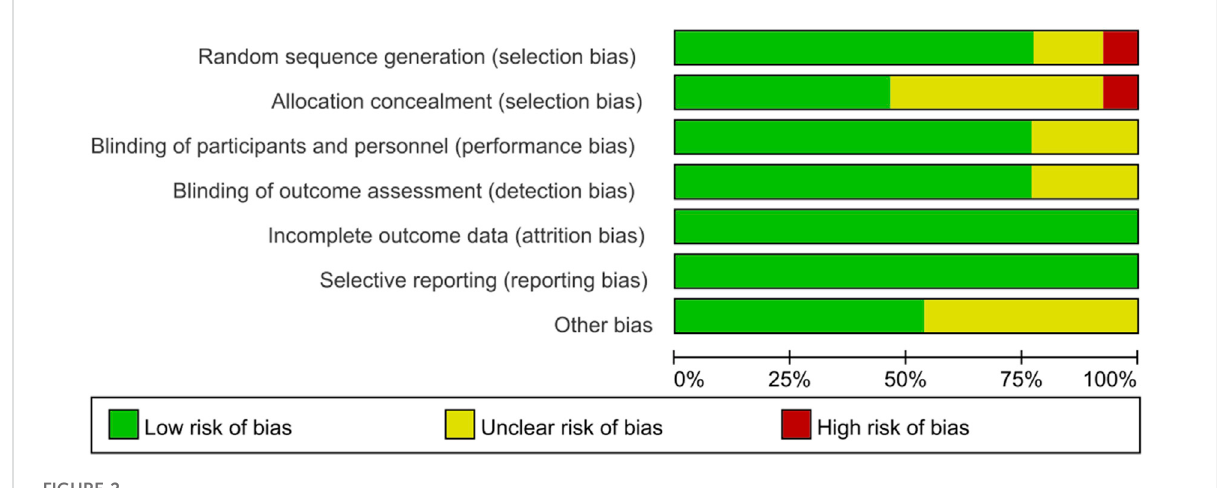
Cochrane Risk of Bias